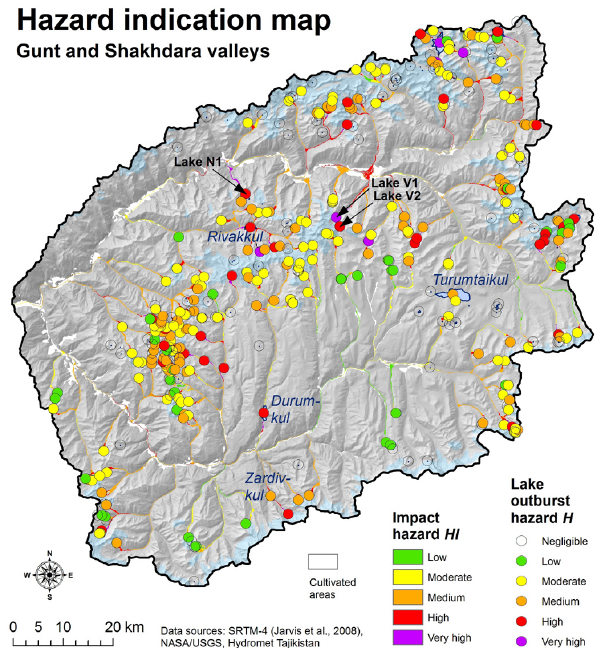
Fig. 8. Hazard indication map for the Gunt and Shakhdara valleys.